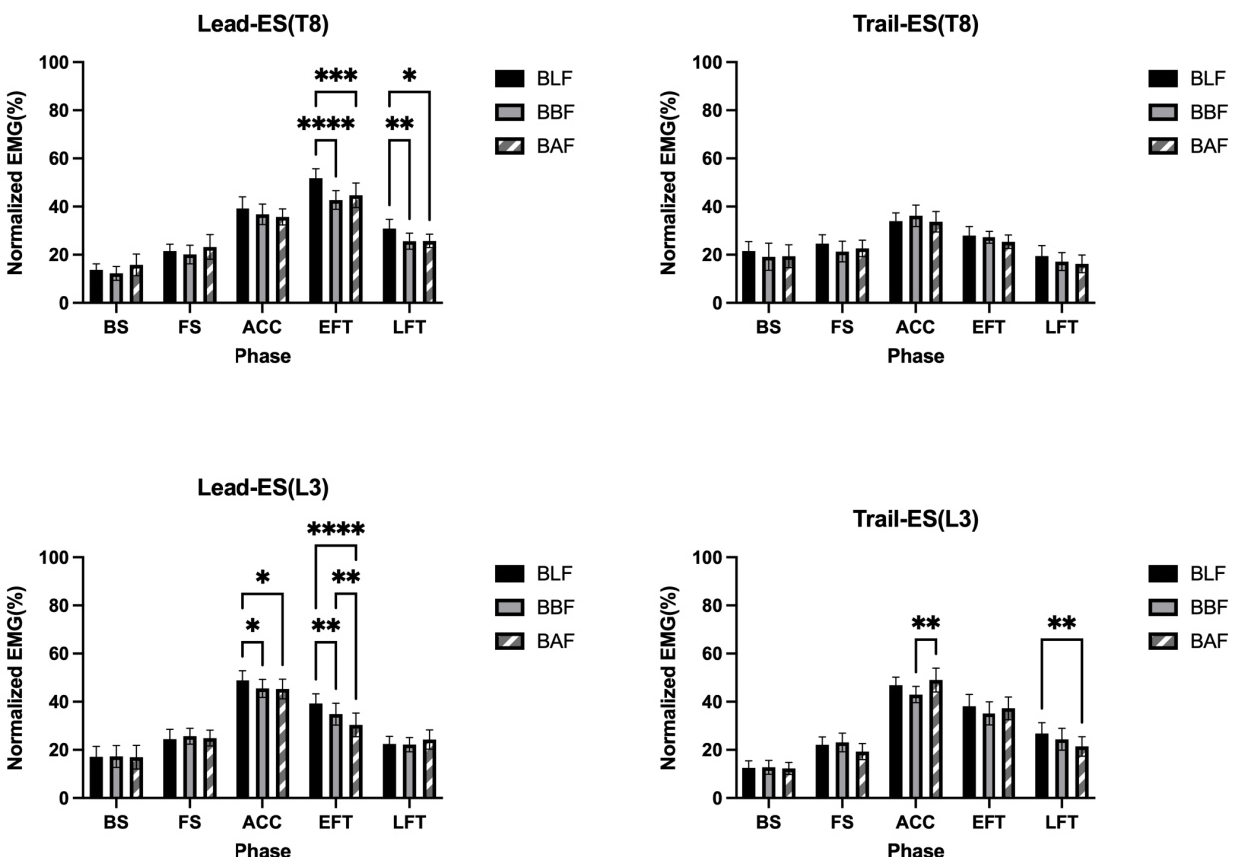
Figure 4. Muscle activities for the lead-ES (T8), trail-ES (T8), lead-ES (L3), and trail-ES (L3) throughout the 5 phases. (BS) backswing, (FS) forward swing, (ACC) acceleration, (EFT) early follow-through and (LFT) late follow-through phase. Comparisons during trials on no slope (BLF), Ball below Feet (BBF) and Ball above Feet (BAF). * p < 0.05, ** p < 0.01, *** p < 0.001, **** p < 0.0001. Table 2. EMG (MVC) by Lead ‐ ES(T8) and Trail ‐ ES(T8) muscle results for the BLF, BBF, and BAF at different events.